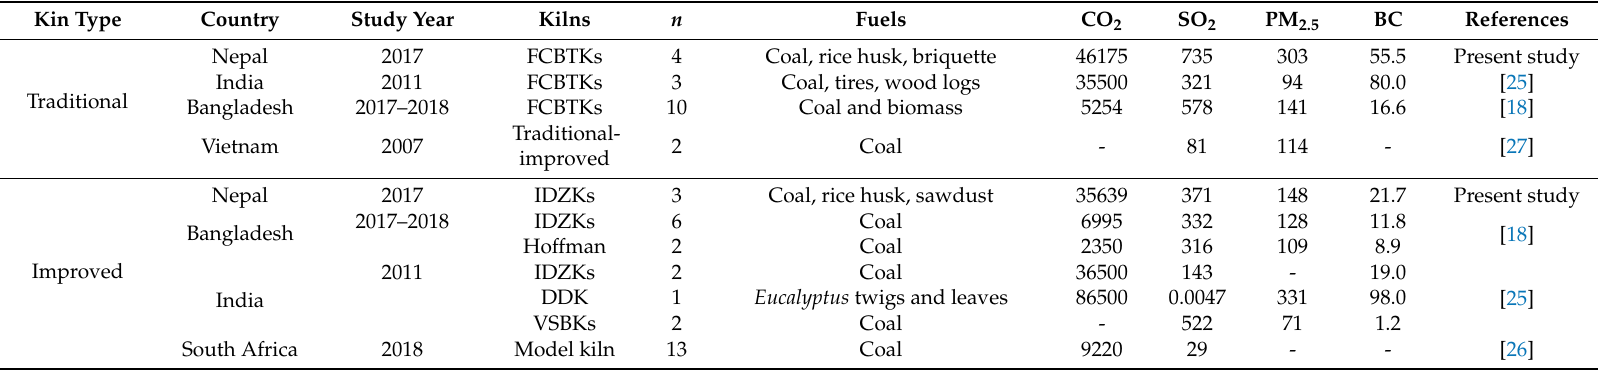
Table 3. Summary of emission concentrations (mg/m 3 ) of different pollutants in normal conditions (25 ◦ C, 1 atm pressure) in this study, compared to previous studies. Kin